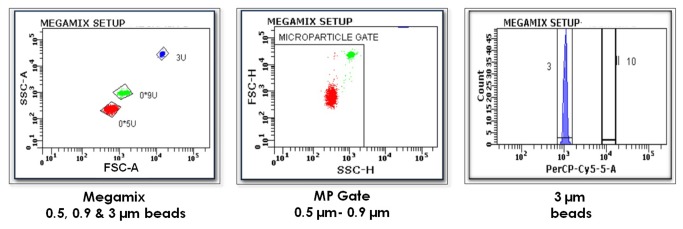
Standardization of microparticle (MP) enumeration. ISTH-“Vascular Biology Workshop”.1st Graph is a graph of forward scatter (FSC-A) vs. side scatter (SSC-A) parameters showing a blend of monodisperse fluorescent beads (Megamix) of three diameters (0.5, 0.9 and 3 µm). 2nd Graph defines the MP gate which includes all events of 0.9 µm and below (microparticles) and excludes all above (cells). 3rd Graph locates the position of 3 µm beads so as to position the 10 µm counting beads 1 log ahead.